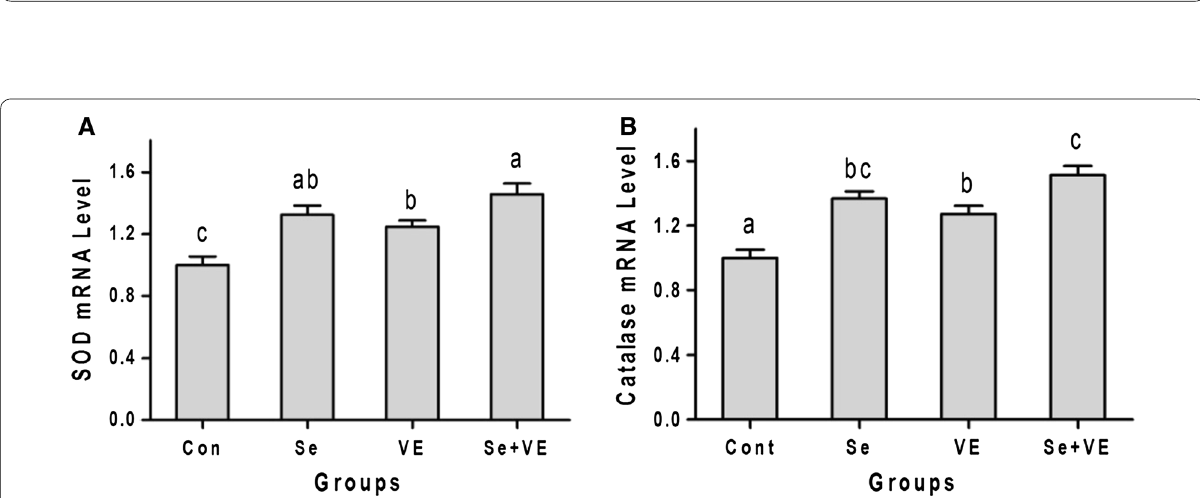
Fig. 4 Effects of Se, VE and Se VE on A SelP concentration and B SelP mRNA Level of breast muscles of heat stressed broiler chickens. Mean values + with their standard errors. The values with unlike superscript letters (a, b, c) in the graph were different (P < 0.05)